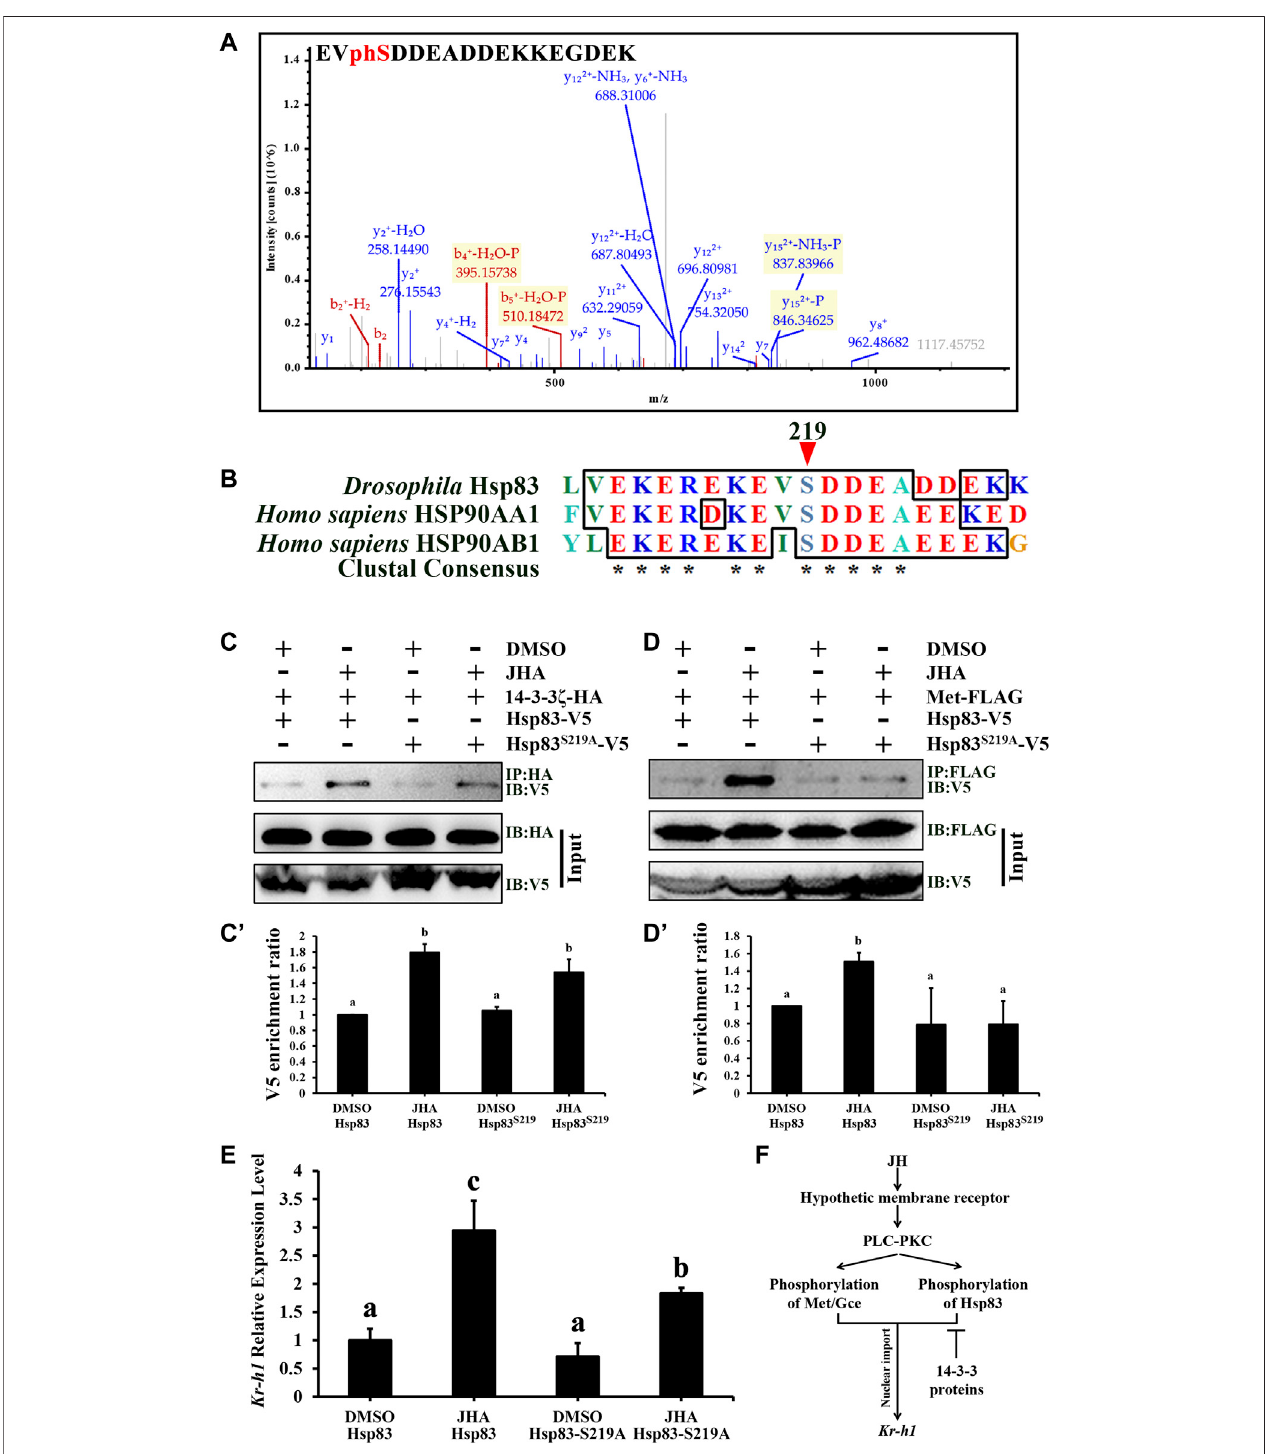
FIGURE 8 | Phosphorylation of Hsp83 induced by JH increases its interaction with Met. (A) Phosphorylated S219 of Hsp83 identi fi ed from the JHA treated Kc cells, as determinedbyLC-MS/MSanalysis. (B) MultiplealignmentofDrosophilaHsp83anditsorthologsinthehuman.ThephosphorylationsiteofDrosophilaHsp83atS219ismarked with a red arrow. (D) melanogaster Hsp83: AAF47734, (H) sapiens Hsp90AA1: NP_001017963.2, and (H) sapiens Hsp90AB1: NP_001258898.1. (C,D) Kc cells were co- transfectedwithAct5c-Gal4,UAS-14-3-3 ζ -HA (C) orUAS-Met-FLAG (D) andUAS-Hsp83-V5orUAS-Hsp83S219A-V5for46 h,andtreatedwith1 μ MJHAorDMSOfor 2 h, and then cell lysates were subjected to immunoprecipitation (IP) with an anti-HA (C) or anti-FLAG (D) antibody, respectively. The interacting proteins were detected by immunoblot(IB). (C ’ ,D ’ ) Quali fi cationofV5ofthewesternblottingresultsin (C,D) usingtubulinasacontrol. (E) DownregulationofKr-h1inthepresenceofJHAbymutationofS219 inHsp83. (F) AmodelshowingthatJHmembranesignalingfacilitatesitsintracellularsignalingbyphosphorylatingMet/GceorHsp83,and14-3-3functionsasanegativeregulator of Met nuclear import. For panels (C ’ ) , (D ’ ) , and (E) , different letters indicate signi fi cant differences using one-way ANOVA followed by Duncan multiple comparisons test.